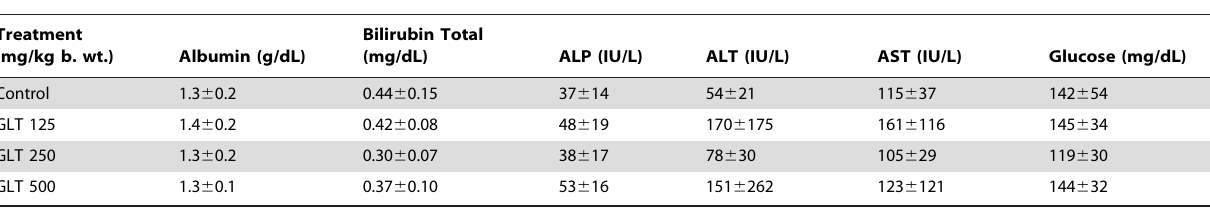
Table 2. Effect of GLT on the liver function and serum glucose.